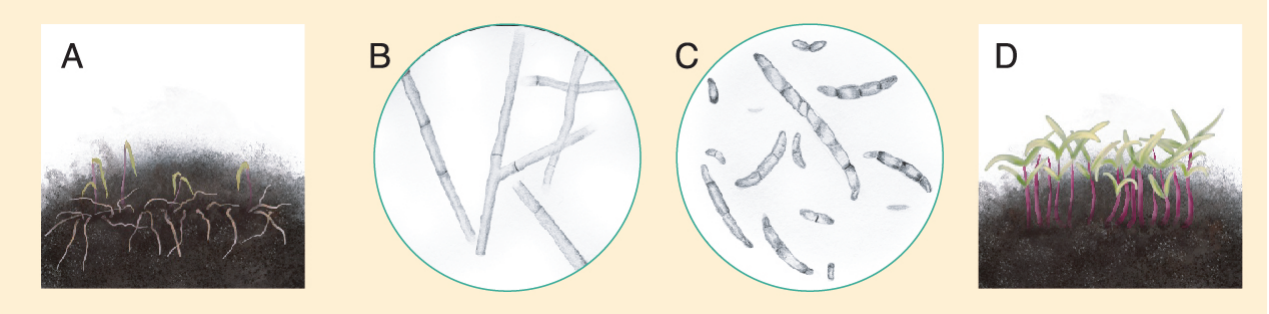
Figure 18. ( A ) Quinoa seedlings affected by damping-off. ( B ) Rhizoctonia spp hyphae. ( C ) Fusarium spp. spores. ( D ) Healthy quinoa seedlings growing under low soil moisture conditions. Source: illustration adapted from Isobe et al. (2019)